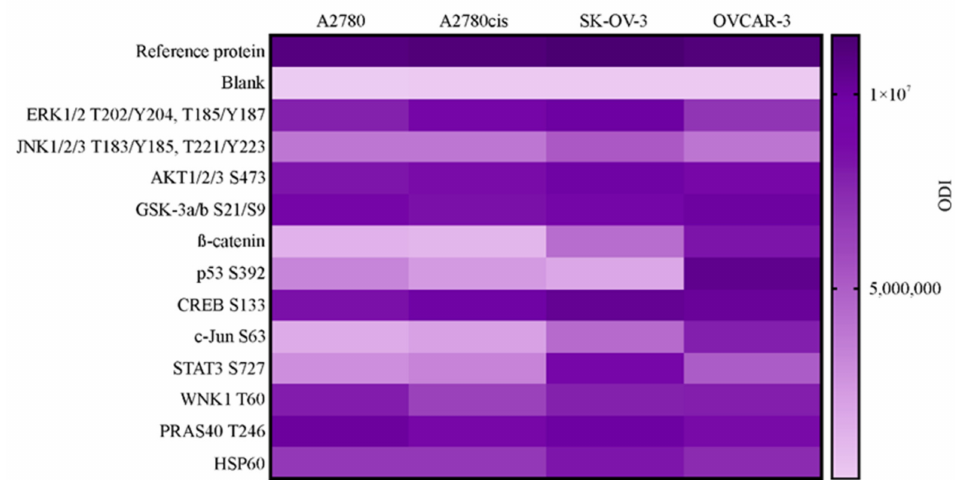
Figure 4. The phosphorylation level of 12 chosen signaling proteins in A2780, A2780cis, SK-OV-3 and OVCAR-3 cell lines. Cultured cells were harvested, lysed and the level of phosphorylated proteins was determined with Proteome Profiler Human Phospho-Kinase Array kit. All samples were made in duplicate. The acquired dots were quantified by densitometric analysis and data are presented as a heat map of the optical density intensity (ODI) of the area under each band’s peak. The level of total and phosphorylated forms of ERK 1/2, AKT and STAT3 proteins in all tested cell lines was evaluated with an independent immunoblotting-ECL assay before subsequent analysis. The antibodies were specifically targeted against total and phosphorylated forms on threonine, and tyrosine residues (ERK 1/2 pThr202/Tyr204) or serine residues (AKT Ser473, STAT3 Ser727) were used to visualize the level of these proteins. As shown in Figure 5a–c, the obtained results confirmed that phosphorylation of pERK 1/2, AKT pS and STAT3 pS was high in all tested cell lines, being the highest in the SK-OV-3 cell line and the lowest in the A2780 cell line.